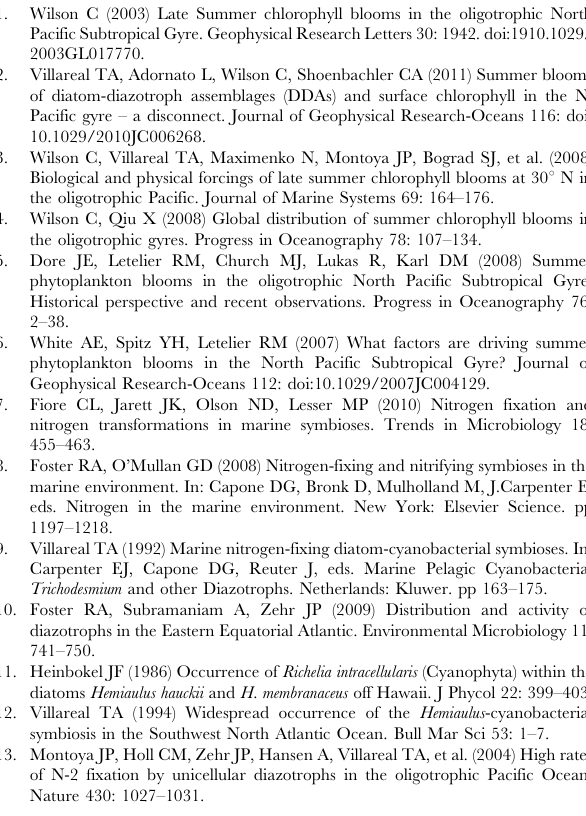
pennate diatoms (cells L 2 1 ), C. R. intracellularis (filaments L 2 1 ), D.